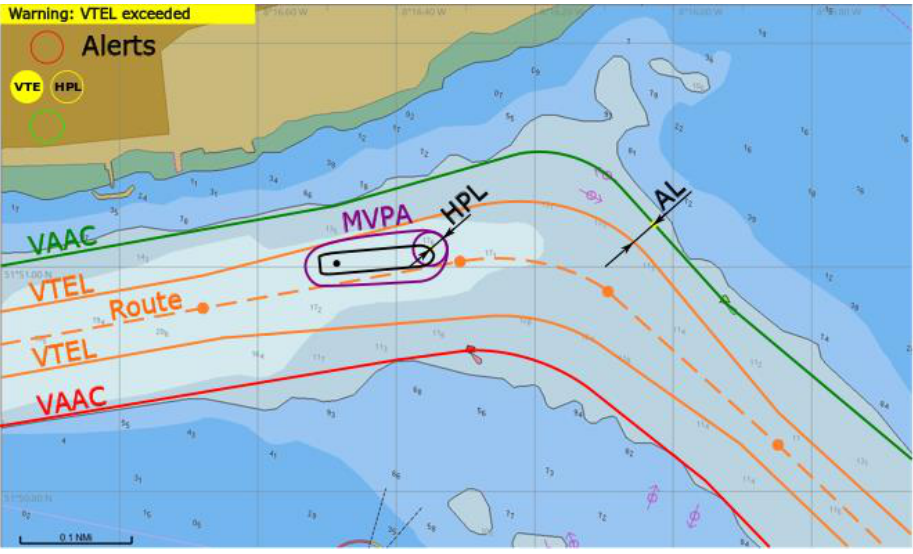
Figure 11. Warning of VTE raised, conceptual presentation in ECDIS.